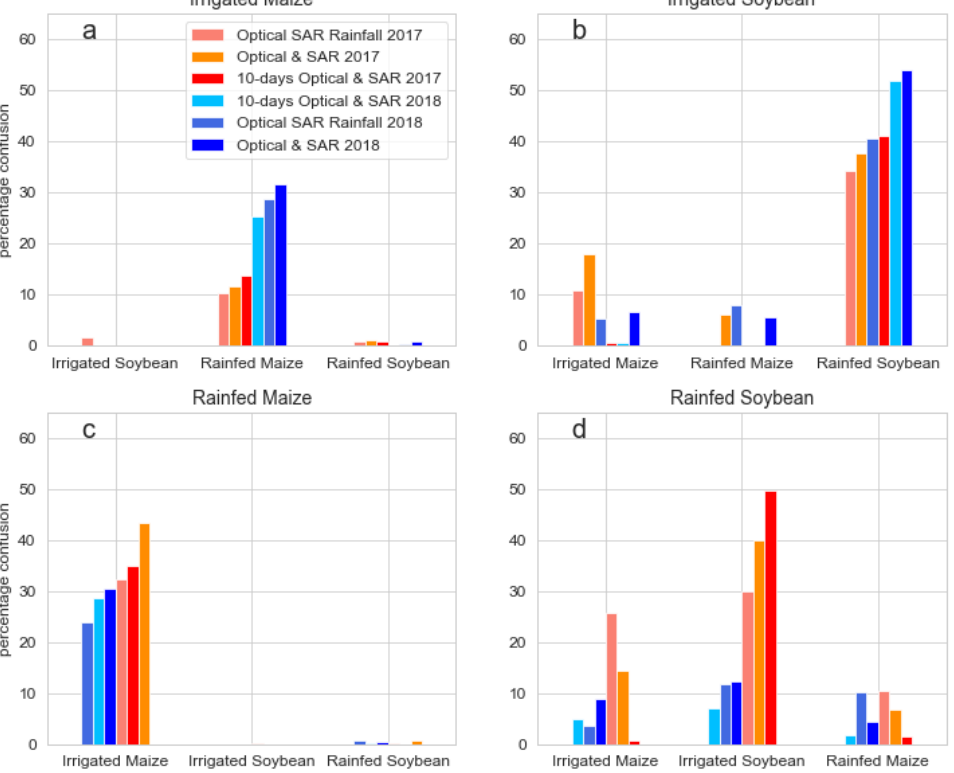
Figure 7. Confusion according to the scenarios. The title of each sub-graph corresponds to the real class and the labels in the horizontal axis refer to the predicted classes. The letter on each graph corresponds to a crop, with ( a ): irrigated maize, ( b ): irrigated soybean, ( c ): rainfed maize and ( d ): rainfed soybean.